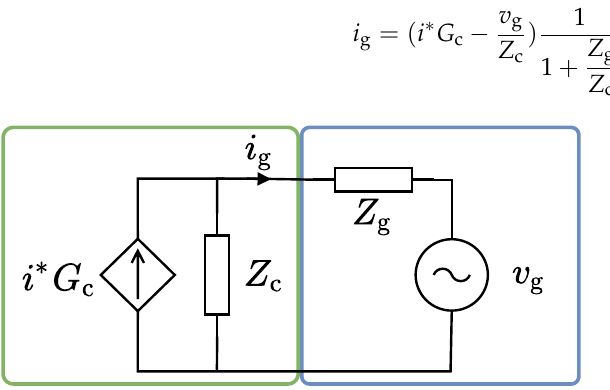
Figure 1. Small-signal representation of an inverter-grid